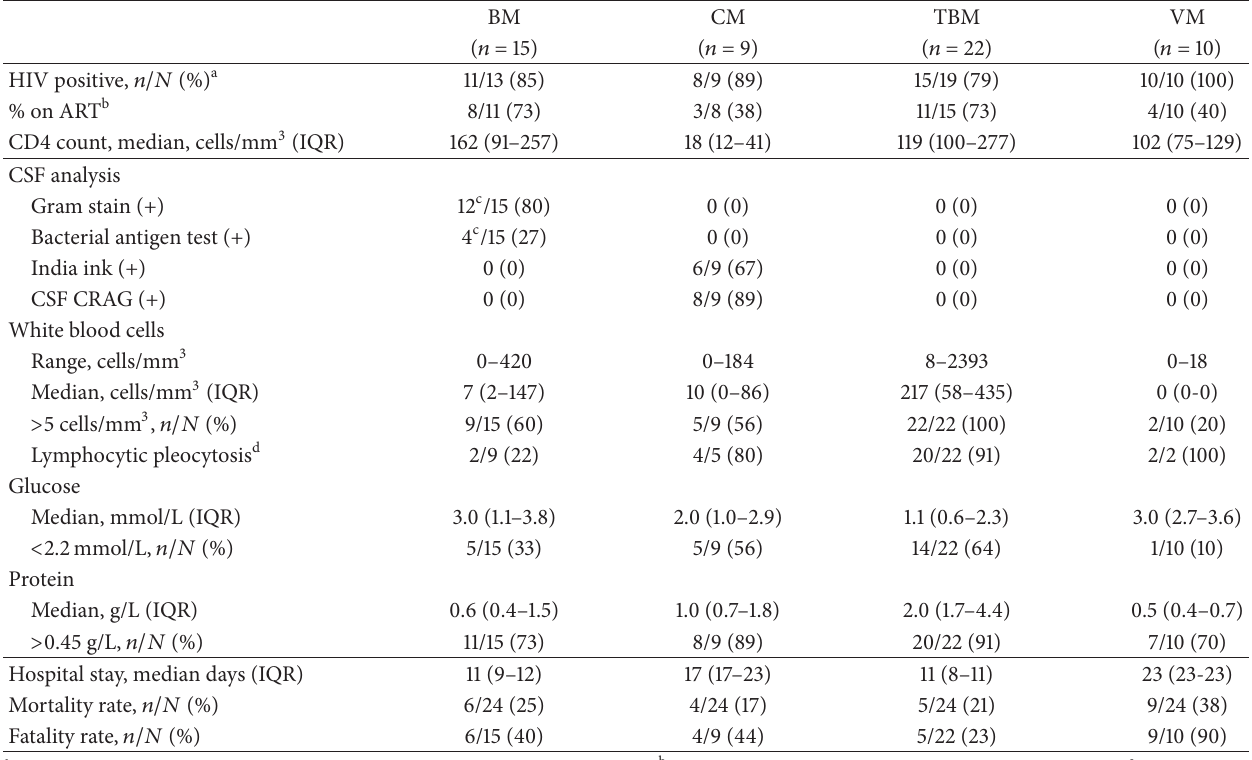
Table 2: Cerebrospinal fluid analysis and clinical